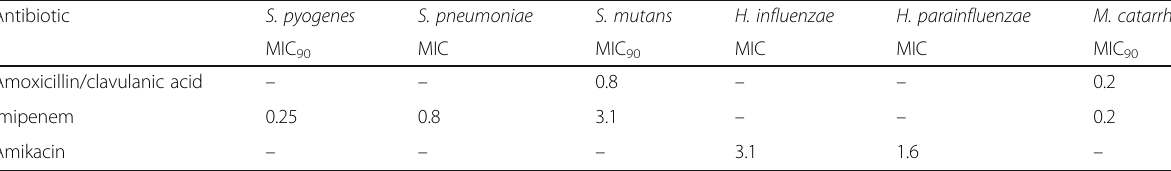
Table 4 Antibacterial activity of antibiotics by broth macrodilution Antibiotic